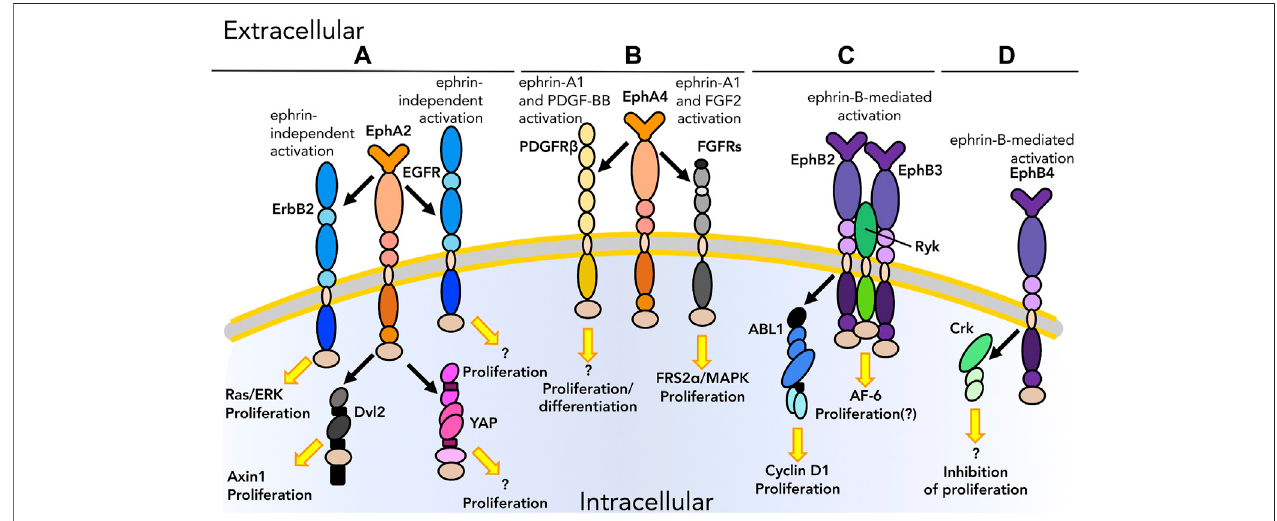
FIGURE 2 | Graphical representation of physical interactions of ephrin receptors (Ephs) with other molecules to form heterotypic protein complex in cis that promote or inhibit cell proliferation and/or differentiation. (A) EphA2 interacts with EGFRs as well as cytoplasmic proteins, such as Dishevelled2 (Dvl2) and YAP, to promote proliferation in tumors in an ephrin independent manner. (B) EphA4 interacts with PDGFR β and FGFRs upon ligand binding to regulate the balance between proliferationanddifferentiationinthenervoussystem. (C) Onceactivatedbytheirephrinligand,EphB2andEphB3formaheterotypicmultiproteincomplexwithRyk duringpalatedevelopmentinmice.EphB2isalsofoundtointeractwithABL1;thisinteractioncausesuncontrolledproliferationintheintestinalepitheliuminthecontextof tumor. (D) Ephs can also impair proliferation, as in the case of the interaction between EphB4 and Crk. As we know only some of the downstream pathways, unknown downstream effectors are listed with a question mark. Receptors are depicted as single chains for simplicity. References are listed in Table 1